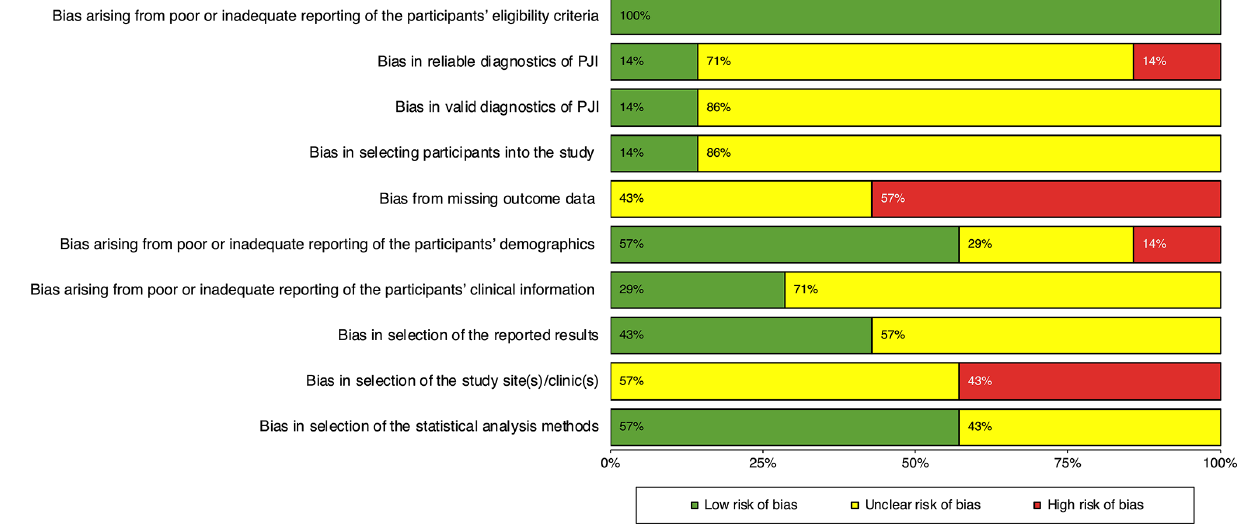
Figure 3. Risk of bias graph: review authors’ judgments about risk of bias items, presented as percentages across the seven studies appraised with JBI’s critical appraisal checklist for case series. JBI: Joanna Briggs Institute; PJI: periprosthetic joint